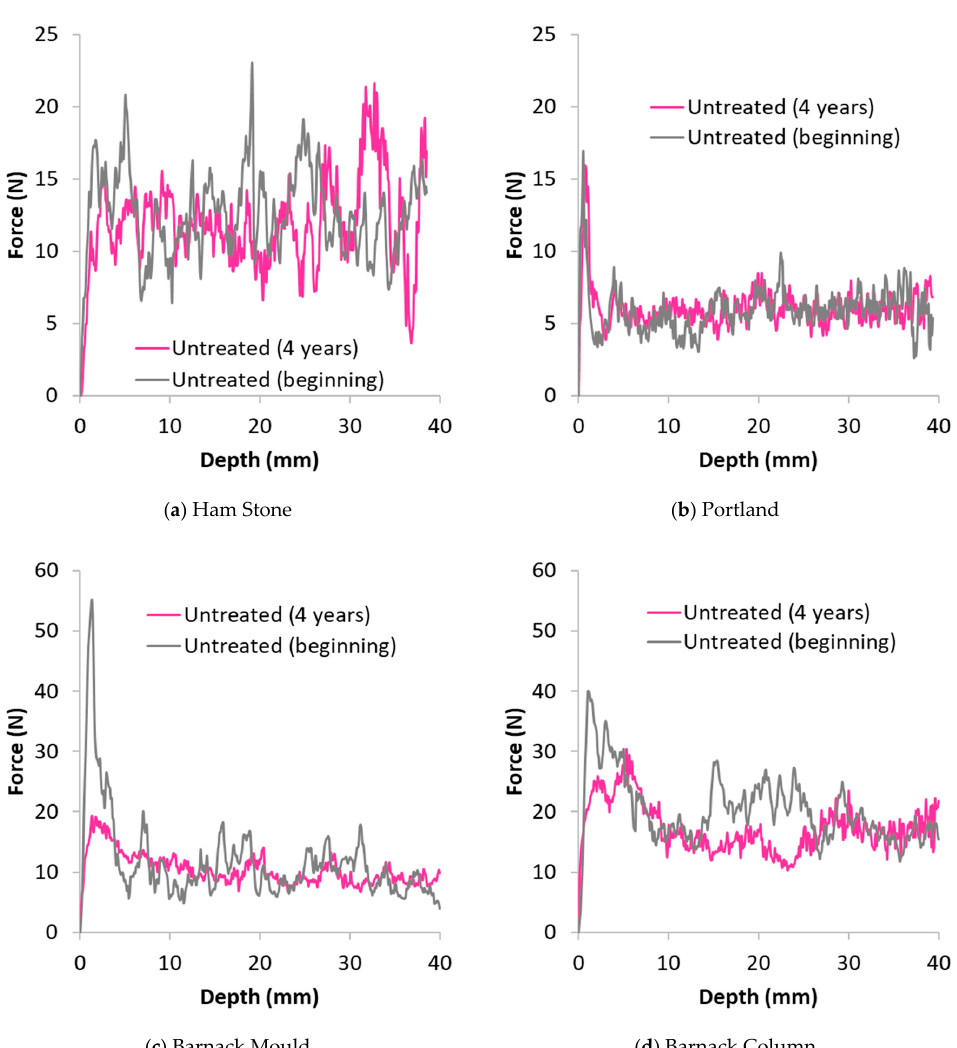
Figure 7. Drilling resistance vs. drilling depth of untreated stone specimens tested at the beginning and at the end of the test. ( a ) Ham Stone; ( b ) Portland; ( c ) Barnack Mould; ( d ) Barnack Column.